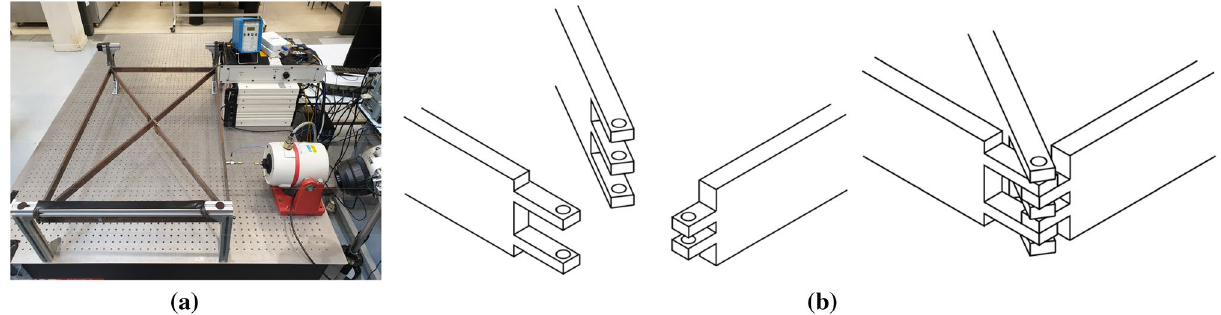
Fig. 13 The a suspended metal frame structure and b drawing of the joint